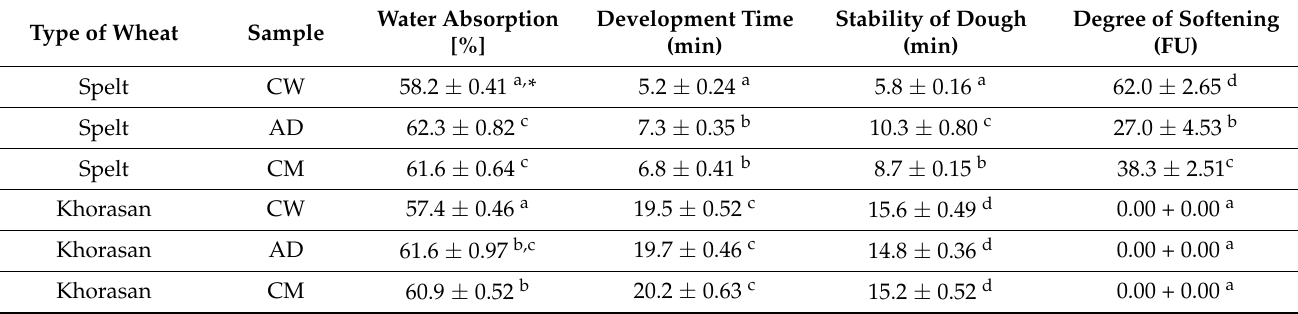
Table 3. Farinograph properties of wheat dough